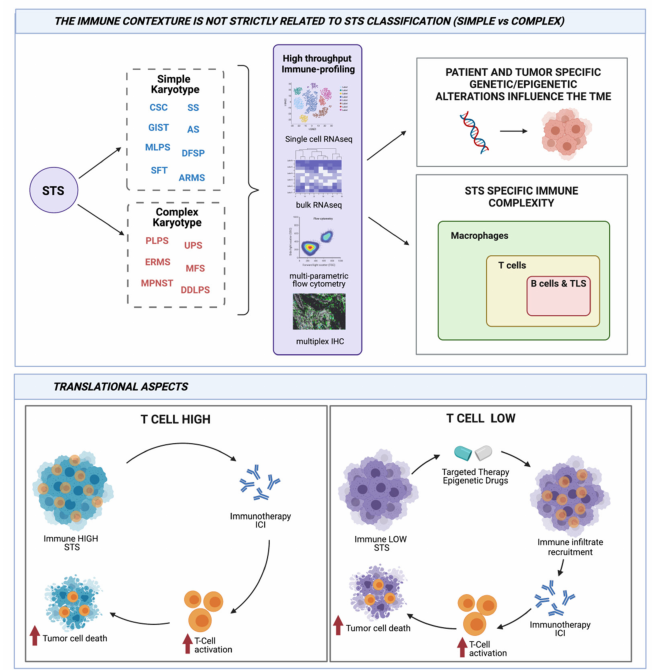
Figure 1. Connection between genetic and immunity in sarcomas and its translational relevance. STS dichotomization in simple and complex karyotypes does not reflect a sharp demarcation of immunogenicity and in situ immune infiltration. Along the characterization of patient- and tumor- related genetic alterations, the actual availability of high-throughput technologies has allowed immune profiling across and within distinct STS histologies. These analyses have highlighted previously unaddressed associations between genetic and/or epigenetic landscapes and peculiar immune contextures. From a translational point of view, while T cell-infiltrated STSs can benefit from immunotherapies, in T cell desert STSs, treatment by targeted or epigenetic drugs should be envisaged as therapeutic strategies to create a host environment potentially amenable to immunotherapies. Created with